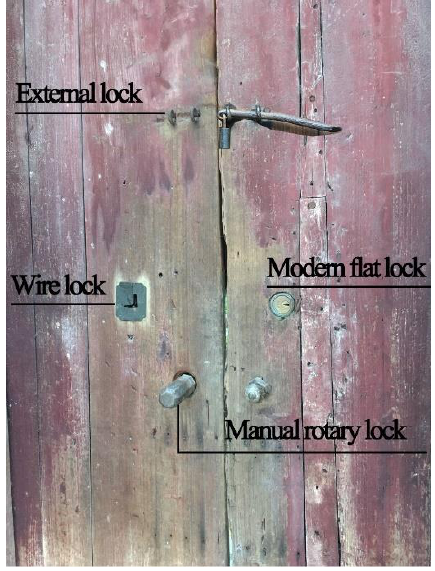
Figure 11. Juxtaposed gate locks (source: the authors).